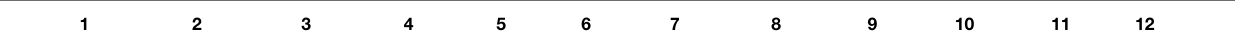
TABLE 1 | Valid cases ( N ), means ( M ), SD, and correlations among key variables. N M